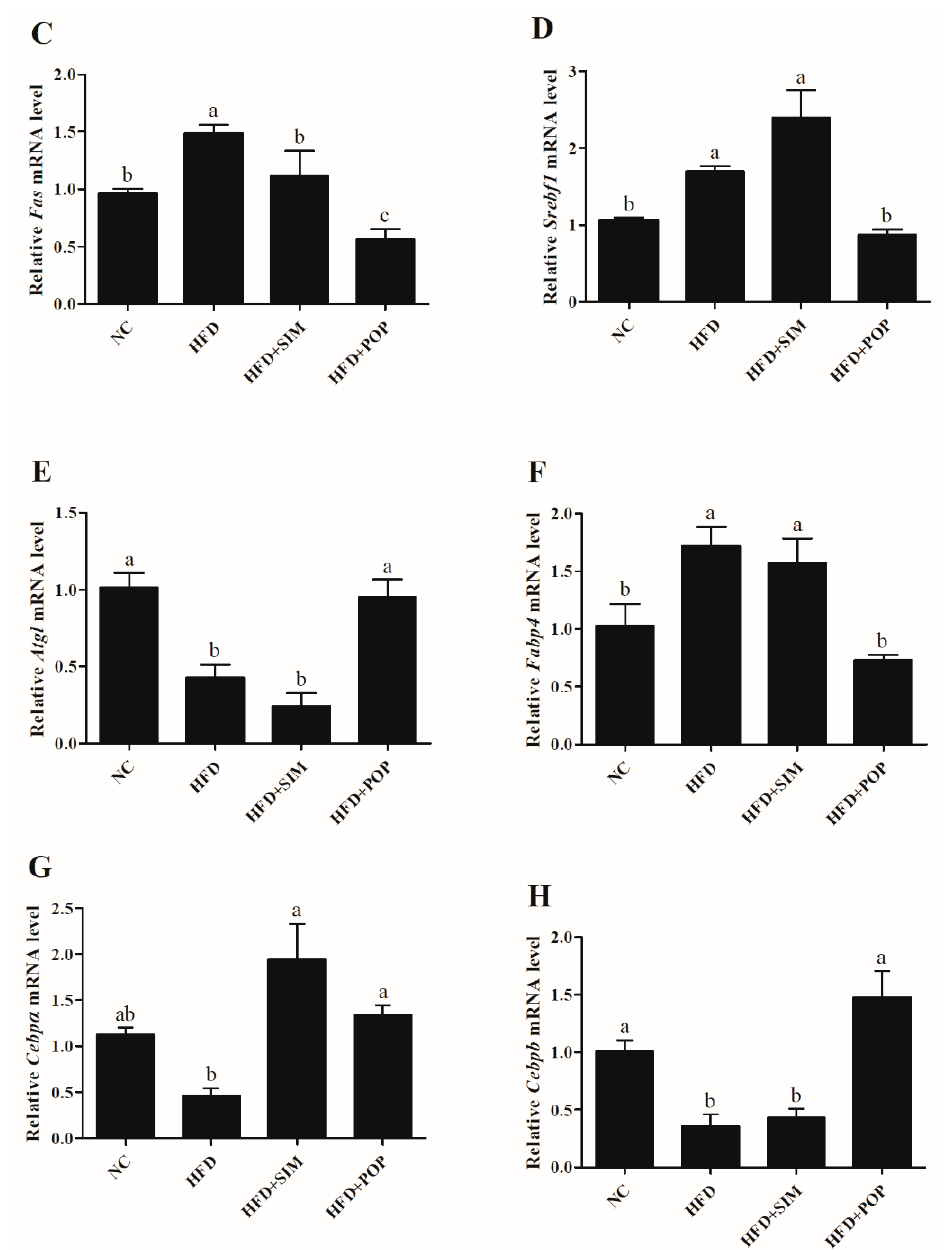
Figure 3. POP treatment modulated the mRNA expression of lipid metabolism-related genes in HFD-fed rats. Quantitative real-time PCR was used to assess ( A ) Ppara , ( B ) Pparg , ( C ) Fas , ( D ) Srebf1 , ( E ) Atgl , ( F ) Fabp4 , ( G ) Cebpa , and ( H ) Cebpb mRNA expression in adipose tissue. NC = normal control, HFD = high-fat diet, HFD + SIM = HFD with simvastatin (1.8 mg/kg), HFD + POP = HFD with P. odoratum polysaccharides (400 mg/kg). All data are presented as means ± SEM. a–c Mean values not sharing a common superscript were significantly different among the groups ( n = 8 for each) ( p < 0.05).